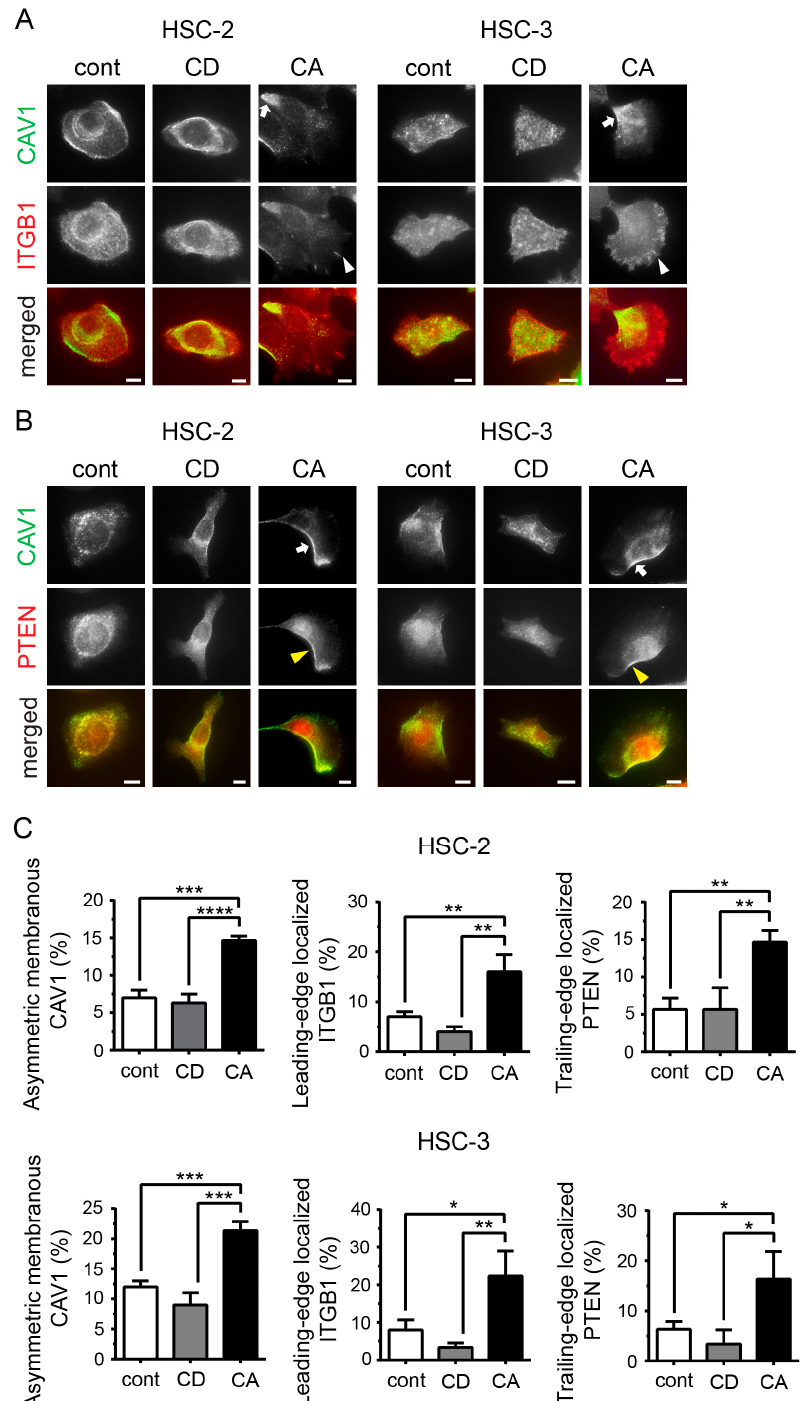
Figure 3. Cholesterol endows cell polarity by asymmetric membranous localization of CAV1. ( A ) Combined immunofluorescence staining of CAV1 and integrin β 1 (ITGB1). Green, CAV1; red, ITGB1. Scale bars, 10 µm. White arrows indicate asymmetric membranous localization of CAV1 at the trailing edge of polarized cells; white arrowheads indicate ITGB1 at the cell leading edge in polarized cells. ( B ) Combined immunofluorescence staining of CAV1 and PTEN. Green, CAV1; red, PTEN. Scale bars, 10 µm. White arrow, asymmetric membranous CAV1 at the trailing edge of polarized cells; yellow arrowhead, PTEN at the trailing edge in polarized cells. ( C ) Percentage of polarized cells as per the asymmetric localization of CAV1, ITGB1, and PTEN. Bar graphs show triplicate results of the percentage of polarized cells expressed as mean ± SD. * p < 0.05, ** p < 0.01, *** p < 0.001, and **** p <